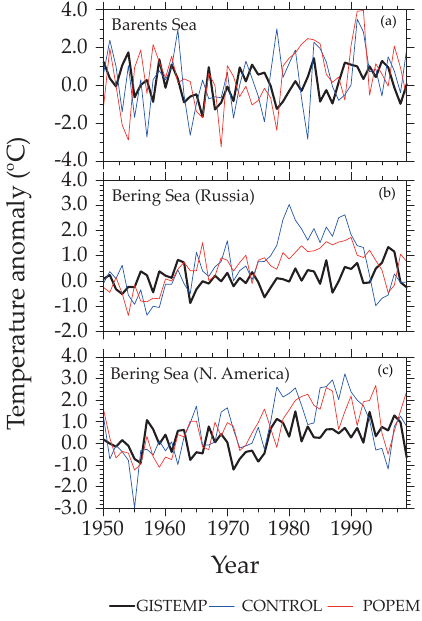
Figure 11. A comparison of the annual mean surface temperature anomaly between GISTEMP, CONTROL, and POPEM from 1950 to 1999. (a) Represents the Barents Sea (68–80 ◦ N, 19–68 ◦ E); (b) Russian part of the Bering Sea (50–65 ◦ N, 150–180 ◦ E); and (c) American part of the Bering Sea (50–75 ◦ N, 140–180 ◦ W). The black line represents observational data (GISTEMP), the blue line is the CONTROL case, and the red is the POPEM case. Anomaly was referenced to 1951–1980